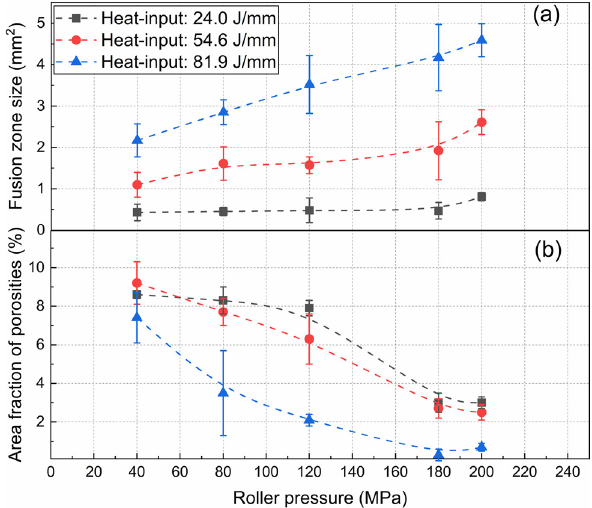
Figure 4: Effect of welding parameters on fusion zone characteris- tics: (a) effect of welding parameters on fusion zone size; (b) effect of welding parameters on area fraction of porosity in laser pressure